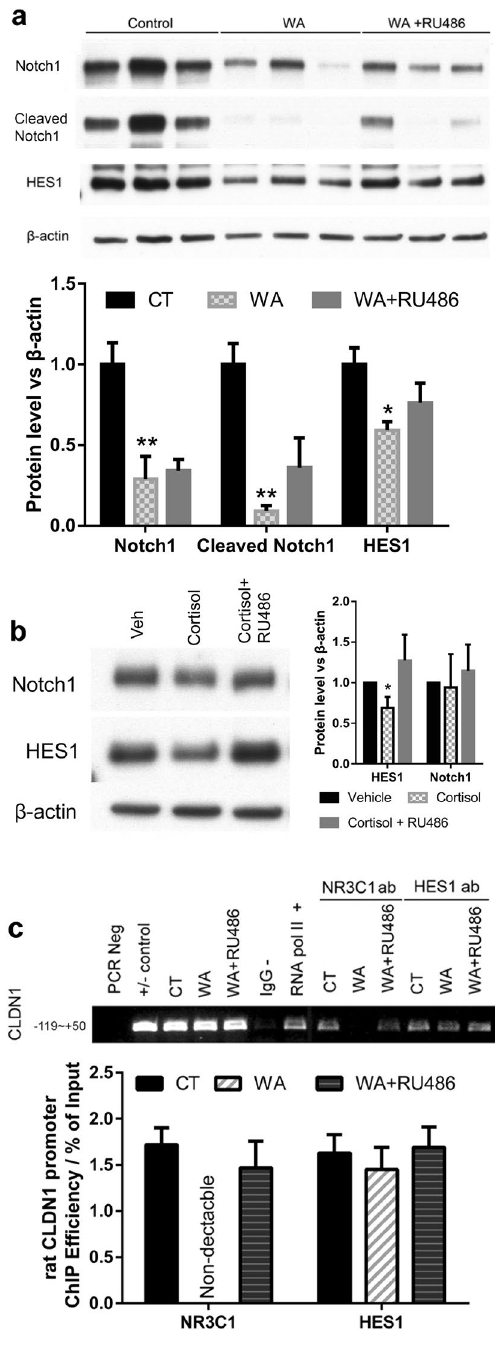
Figure 4. CLDN1, NR3C1, and HES1 in WA stress rat crypts. ( a ) Western blotting analysis of colon crypts isolated from control, WA and WA + RU486 rats. Notch signaling target HES1 was down-regulated in WA stress rats ( P < 0.05) and RU486 intervention modestly affected HES1 protein levels (P = 0.19). (n = 3; * P < 0.05). Significant down-regulation of Notch1 and cleaved Notch1 protein levels in the WA stressed rat colon crypts are also observed (n = 3; ** P < 0.01). (Pre-cropped blots are included in a Supplementary Information.) ( b ) Caco2/BBe cells are treated with 500 nM cortisol or 500 nM cortisol + 500 nM RU486 24 h later seeded with 50–60% density, cells are harvested after 24 h treatment for Western blotting analysis. HES1 was showed 31.1 ± 7.9% down-regulation upon cortisol treatment (n = 3; * P < 0.05). ( c ) Chromatin Immunoprecipitation (ChIP) analysis of the interaction between rat CLDN1 gene promoter and NR3C1 or HES1 in rat colon crypts isolated from control (CT), WA stress rats, and stressed rats with RU486 intervention (WA + RU486). PCR primers targeting ( − 119 ~ + 50) of rat CLDN1 promoter was used to detect immunoprecipitated product. ChIP analysis showed that both NR3C1 and HES1 bind to CLDN1 promoter region containing GREs and N-boxes. A significant decrease of NR3C1 binding to CLDN1 promoter was observed in colon crypts from WA stressed rats, and RU486 intervention prevented this change. (n = 3; P <